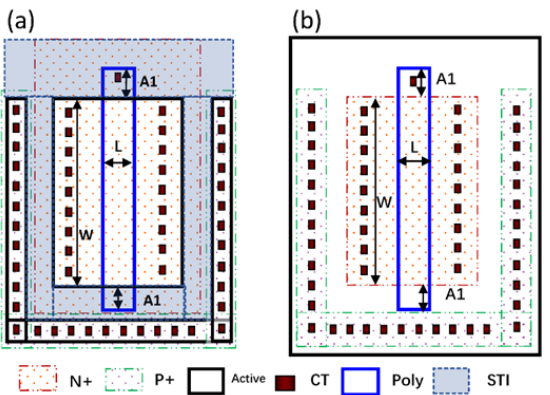
Figure 7. The schematic layout of a single transistor with ( a ) STI and ( b ) merged active